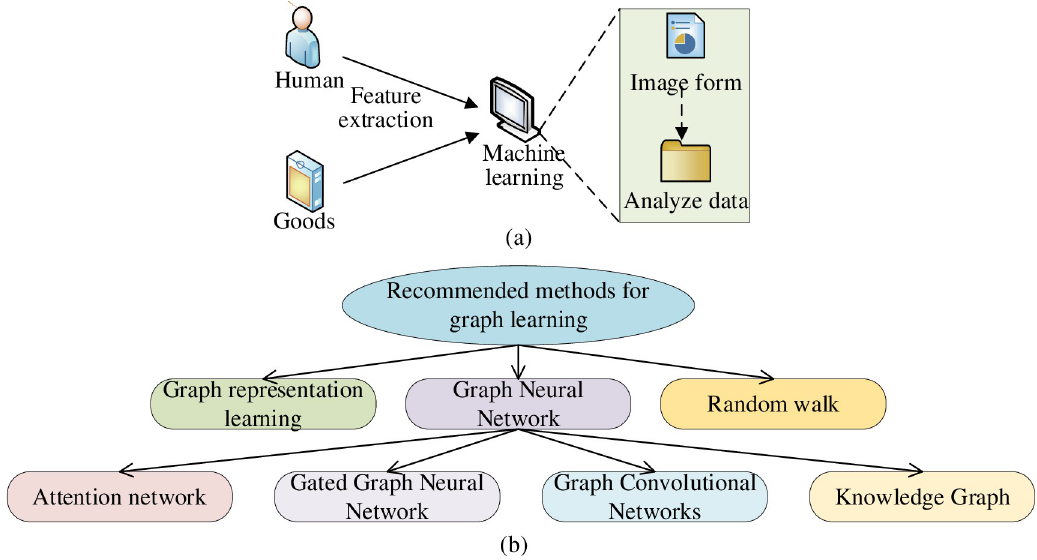
Fig 2. Basic principle and classification of GL-based PRS (a is the basic principle, b is the classification).